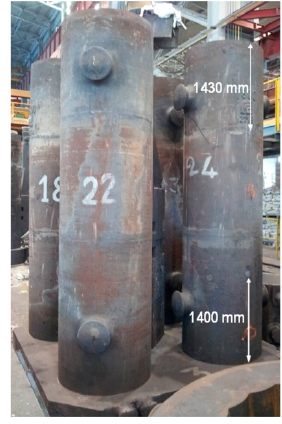
Figure 1. Four-mold system equipped with thermocouple.